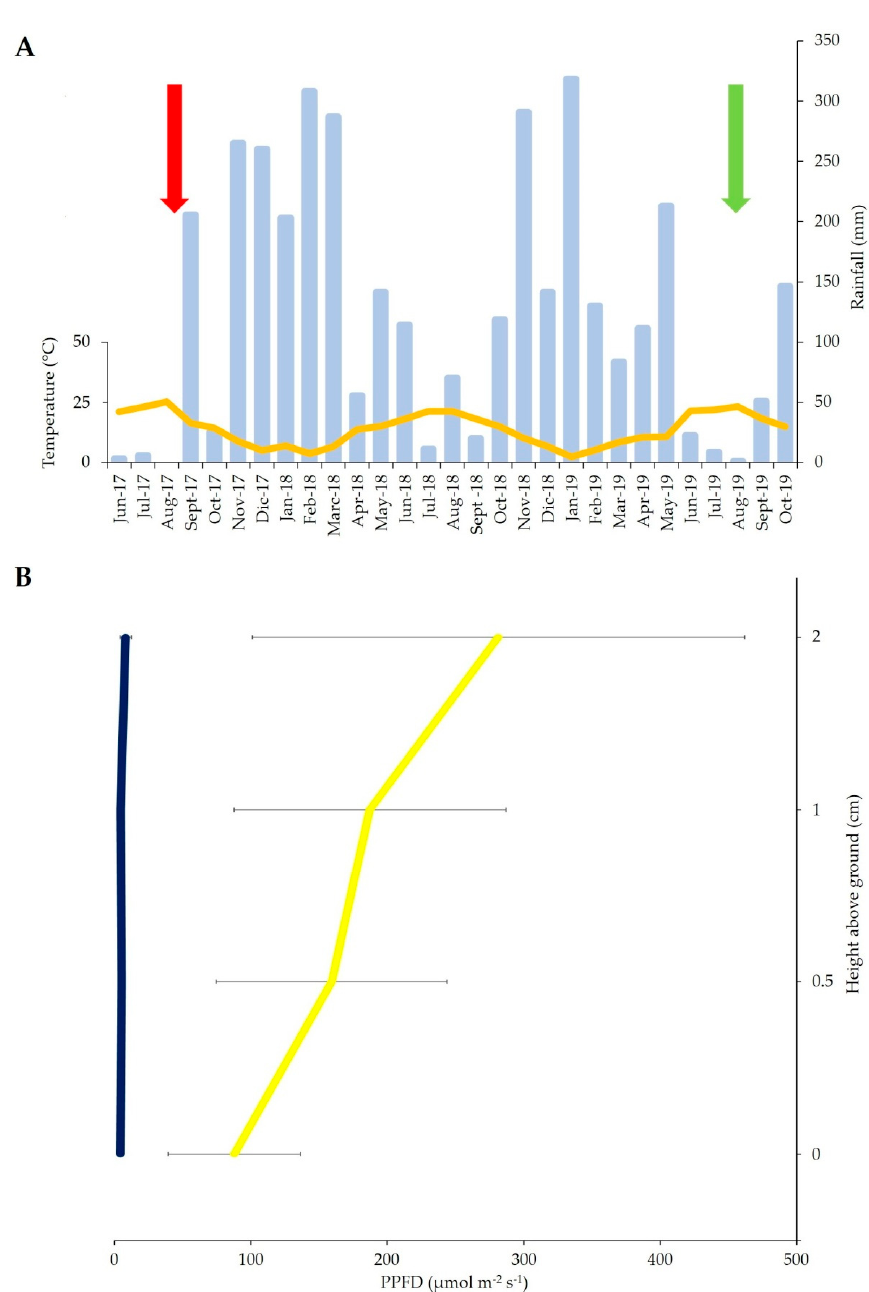
Figure 2. ( A ) Values of mean monthly temperatures ( ◦ C, orange curve) and total monthly rainfall (mm, light blue bars) of the study area during the 2017–2019 period calculated by daily data recorded by Multi-risk Civil Protection Functional Centre of Campania Region, Agerola station (red and green arrows indicate the time of wildfire event and field samplings, respectively). ( B ) Average values ± standard deviations of photosynthetic photon flux density (PPFD) in control closed-canopy (blue) and burned canopy gap (yellow)